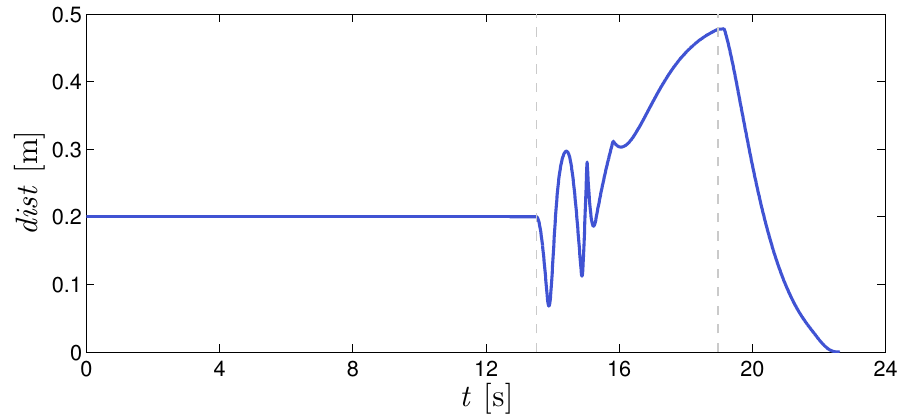
Figure 11. The distance of the transported beam from the obstacles. The values of the joint angles, obtained for the torso and the left and right arm, were mean normalized, i.e., scaled to a 0.5 to 0.5 range, in order to fit in the same range, and − are presented in Figures 12–14, respectively. As can be seen, according to the assumed form of mapping D M ( q ) , all values remained as close as possible to the middle of the ranges permitted. The values close to the limitations resulted from the given initial configuration or the requirements of the task, such as obstacle avoidance or reaching a given position and